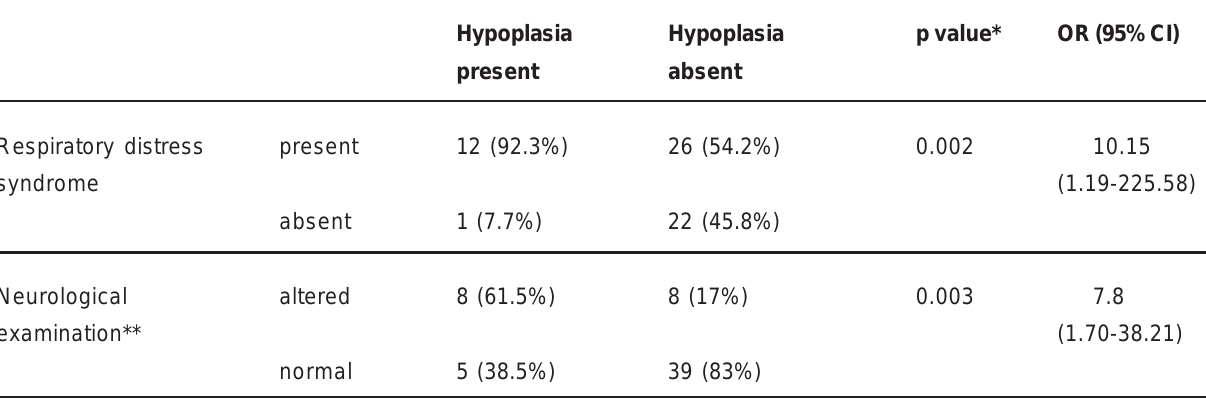
TABLE 4- Association between enamel hypoplasia, respiratory distress syndrome and neurological examination at discharge in preterm